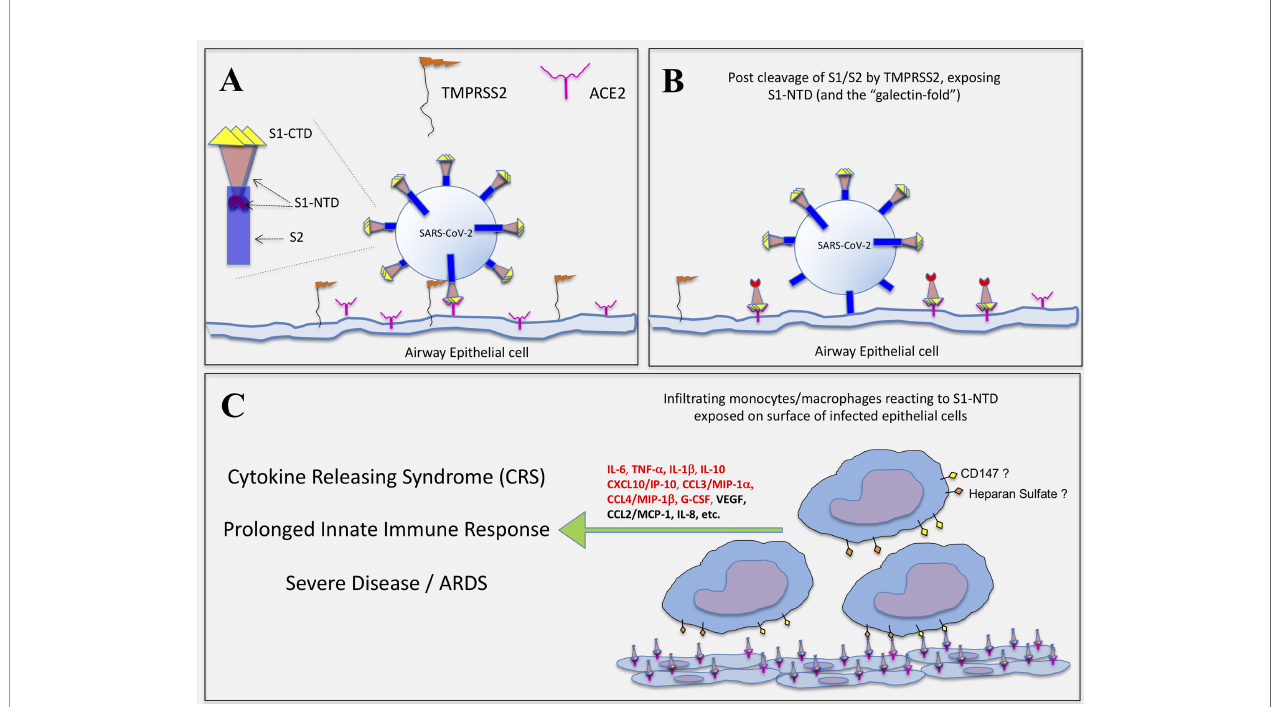
FIGURE 5 | Hypothetical representation of how SARS-CoV-2 infection exposes the S1-NTD (and “ galectin-fold ” ) on epithelial cells for potential activation of in fi ltrating monocytes. (A) SARS-CoV-2 infection of epithelial cells is initiated with the binding of S1-CTD/RBD to ACE2. The serine protease, TMPRSS2, expressed on host cells then cleaves the spike protein at the S1/S2 linkage. (B) The S2 subunit undergoes structural changes, serving fi rst to anchor the virus and then facilitating its entry into the cell. It is proposed that the S1/S2 cleavage event simultaneously exposes the S1-NTD, which extends outward as the S1-CTD/RBD remains bound to ACE2. (C) In fi ltrating monocytes/macrophages are then activated to produce COVID-related cytokines via cell surface glycoproteins (e.g. CD147) and/or polysaccharides (e.g. Heparan Sulfate) interacting with S1-NTD, which mimics EC-Gal-3. Those cytokines indicated in red type were signi fi cantly impacted by the S1 subunit in this